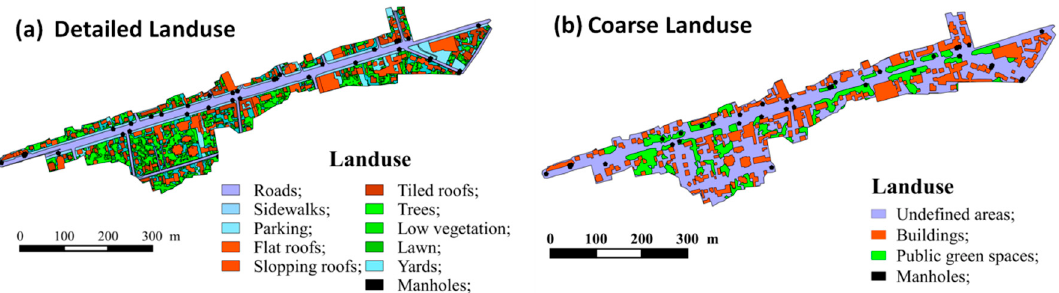
Figure 5. Input land-use information ( a ) obtained by combining multiple data sources, (detailed land-use); ( b ) extracted directly from the BD-TOPO ® database (coarse land-use).